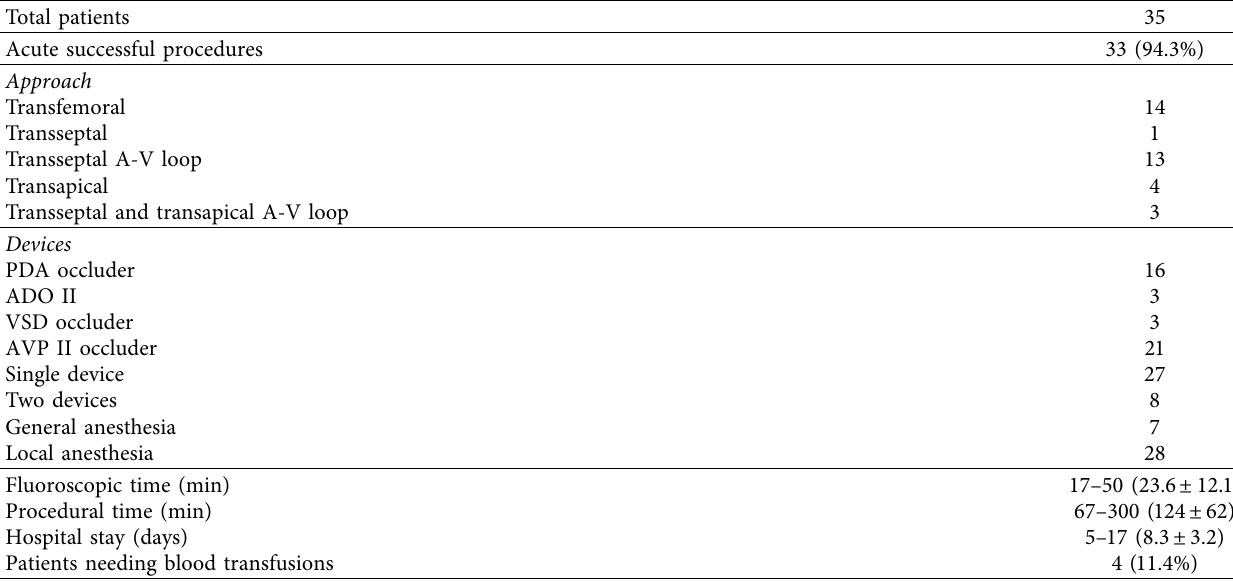
Table 2: Procedural characteristics.